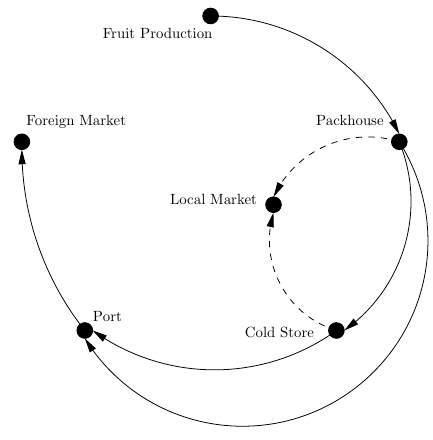
Figure 1: Simplified schematic of fruit flow in the South African export supply chain. The 850 pack houses and 286 cold stores countrywide where fresh fruit is packed and cooled (excluding those at the ports) were grouped into 31 pack house and cold store